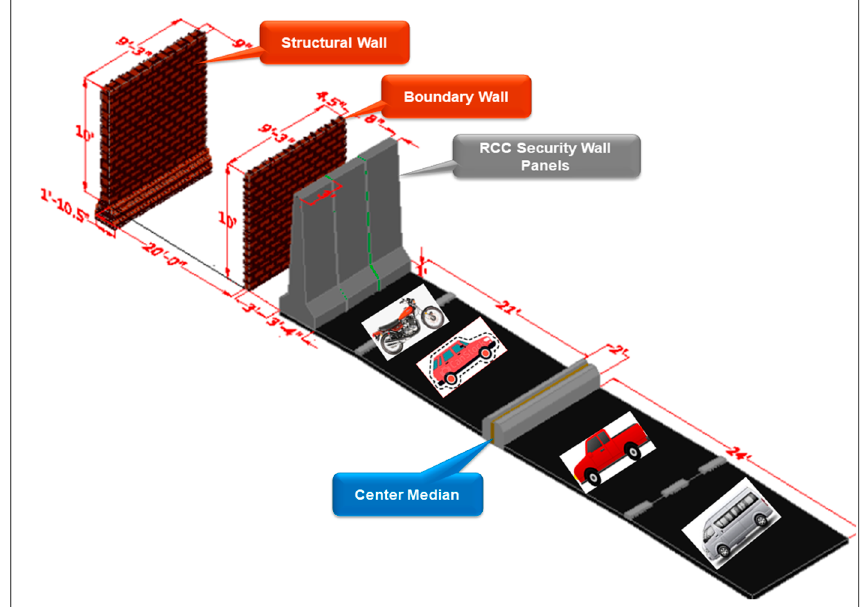
Figure 3. Existing arrangements of blast protection wall panels.